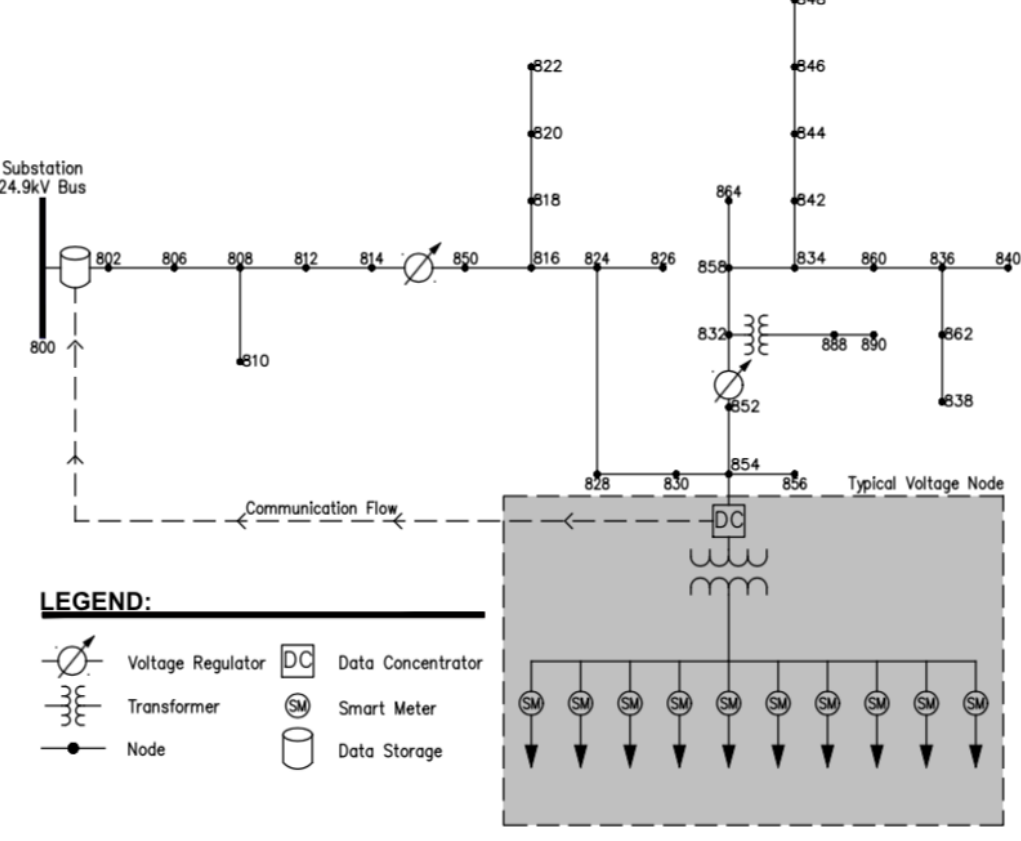
Figure 1. The IEEE 34 bus feeder single line diagram. Modified from [10].